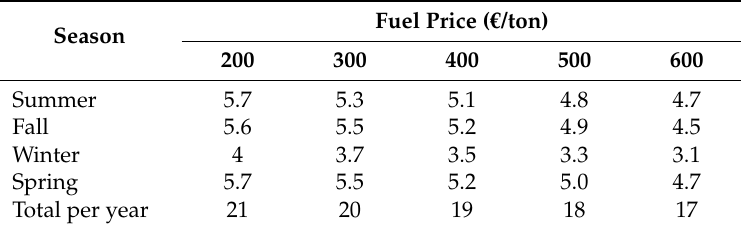
Table 43. Effect of fuel price on the optimal number of round trips for double freight